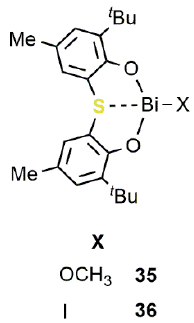
Figure 20. Bi(III) complexes 32–33 containing an [OSO]-bisphenolate ligand [79].